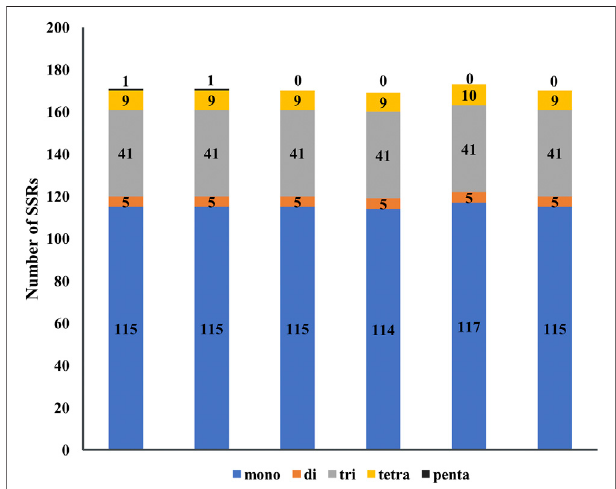
FIGURE 5 | Analysis of simple sequence repeats in the chloroplast genome of six Agropyron species. Numbers indicate SSR types detected in each species. X -axis: name of the species. Y -axis: number of SSR.